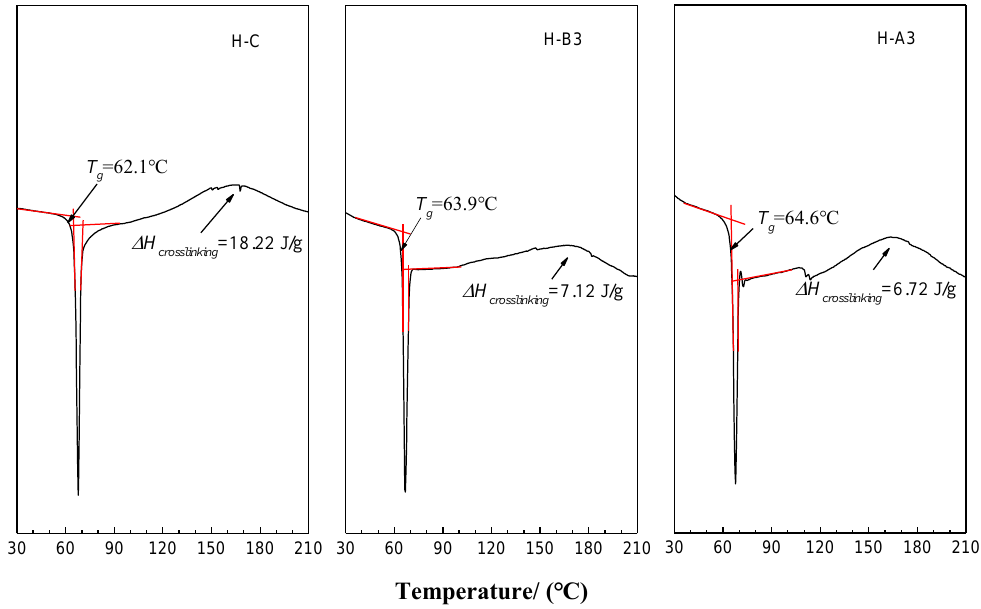
Figure 17. DSC thermograms of hybrid-based coatings with and without the addition of fillers.